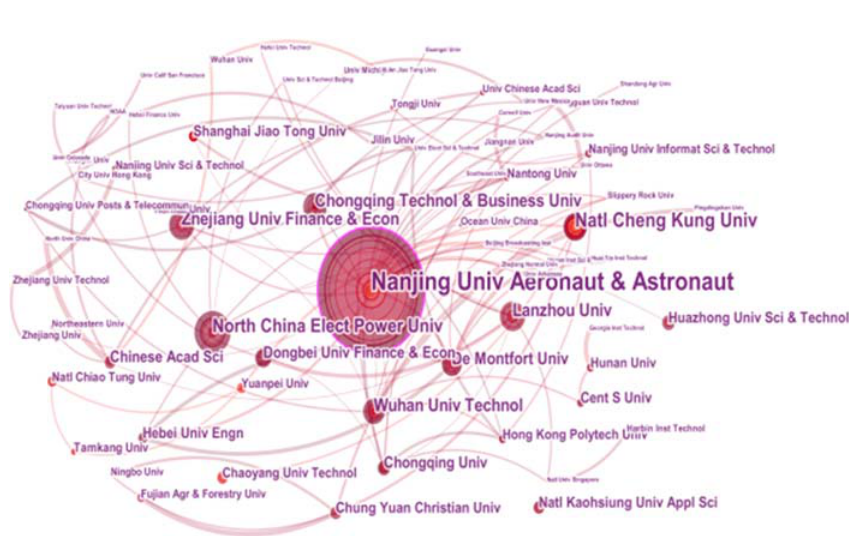
Figure 6. Network of